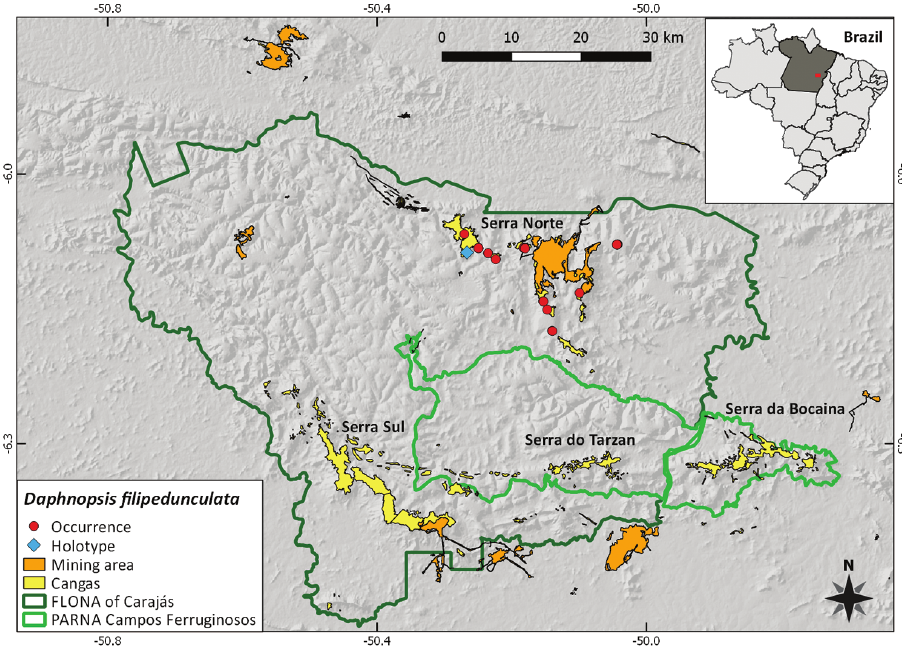
Figure 3. Distribution of Daphnopsis filipedunculata Nevling & Barringer along the Serra dos